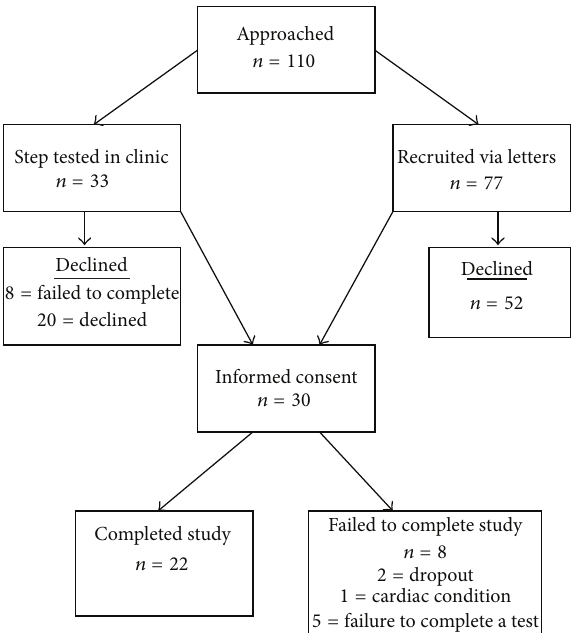
Figure 1: Flow chart displaying number of RA patients who were approached, recruited and completed the